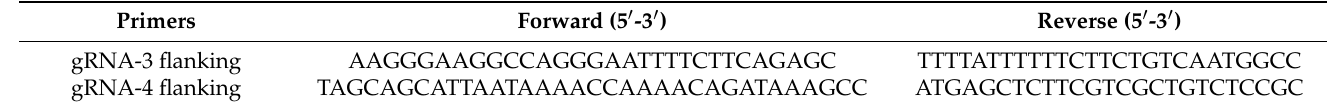
Table 1. The primers used in the T7E1 mismatch cleavage assay.